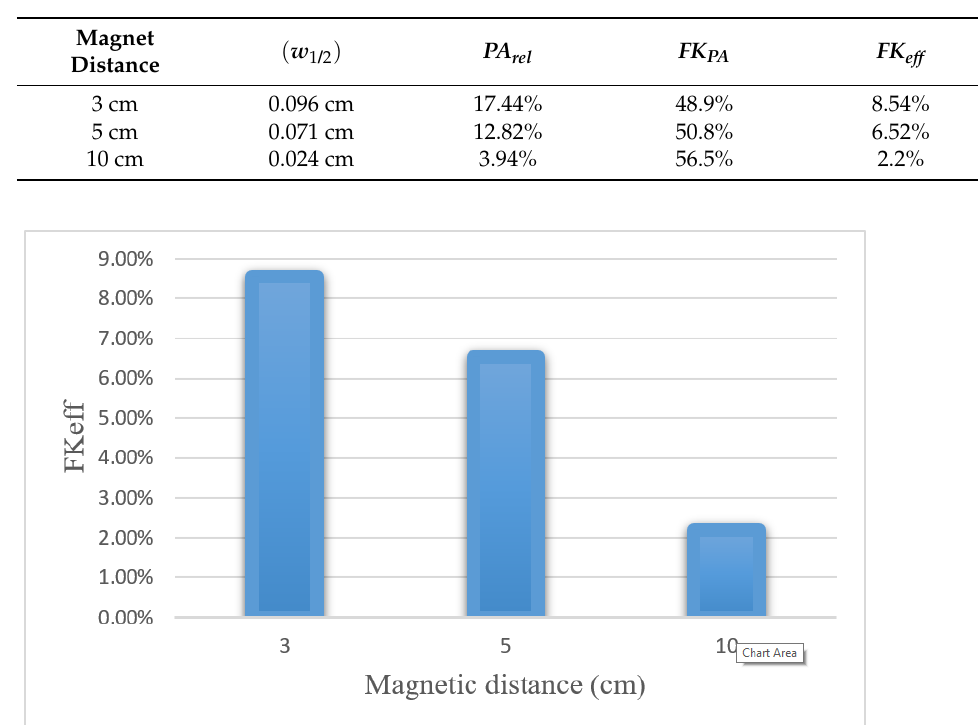
Figure 22. Comparison of FK eff for different magnetic distances after 60 min of treatment.